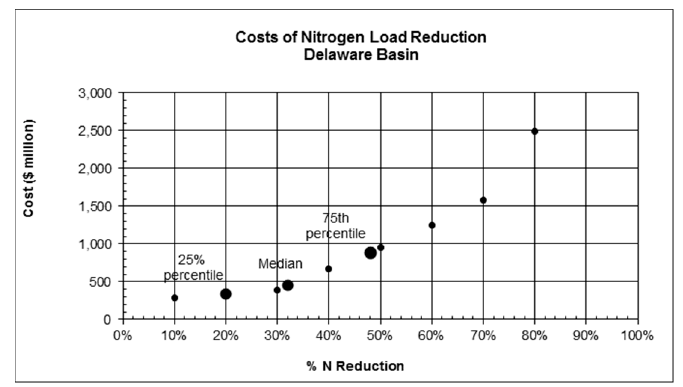
Figure 15. Nitrogen reduction cost curve for the Delaware Basin (in 2010 dollars).